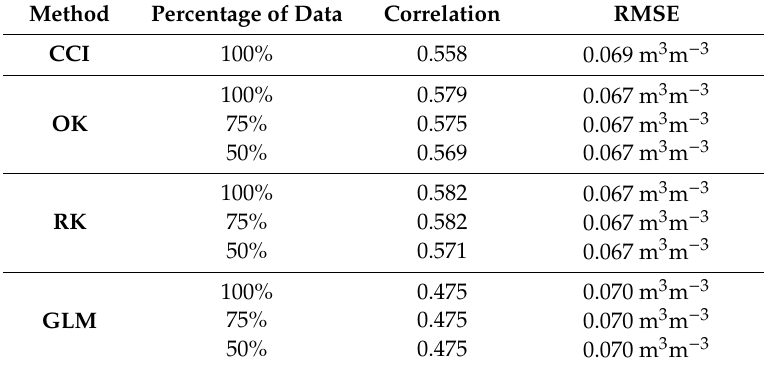
Table 3. Overall correlation coe ffi cients between all ground-truth validation points and the CCI soil moisture product, as well as gap-filled outputs. Percentages show the data subset used to predict soil moisture values over the region of